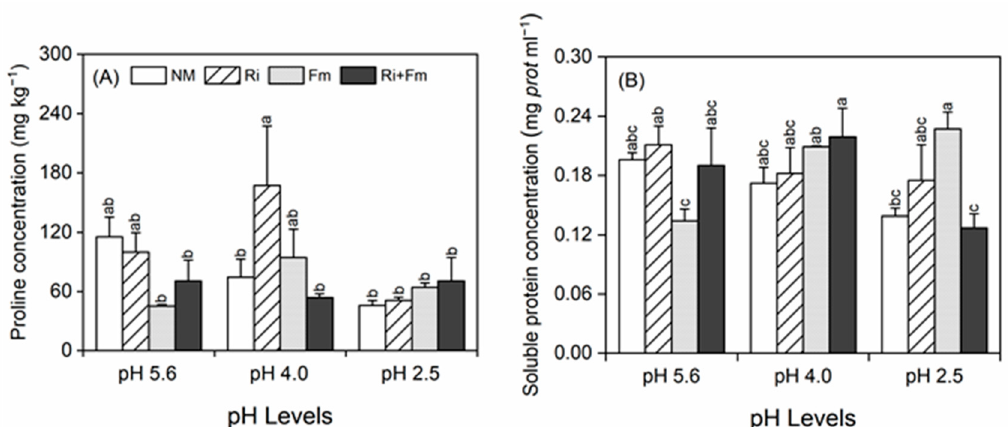
Figure 3. Effects of arbuscular mycorrhizal fungi on proline concentration ( A ) and soluble protein concentration ( B ) of Torreya grandis under acid rain with pH 5.6, 4.0, and 2.5. NM, Ri, Fm, and Ri+Fm represent the four AMF treatments: inoculation with no mycorrhizal fungi, with Rhizophagus irregularis, with Funneliformis mosseae , and with the combination of the two fungi inoculum, respectively. Values are presented as the mean ± SE ( n = 4). Different letters indicate a significant difference ( p < 0.05).